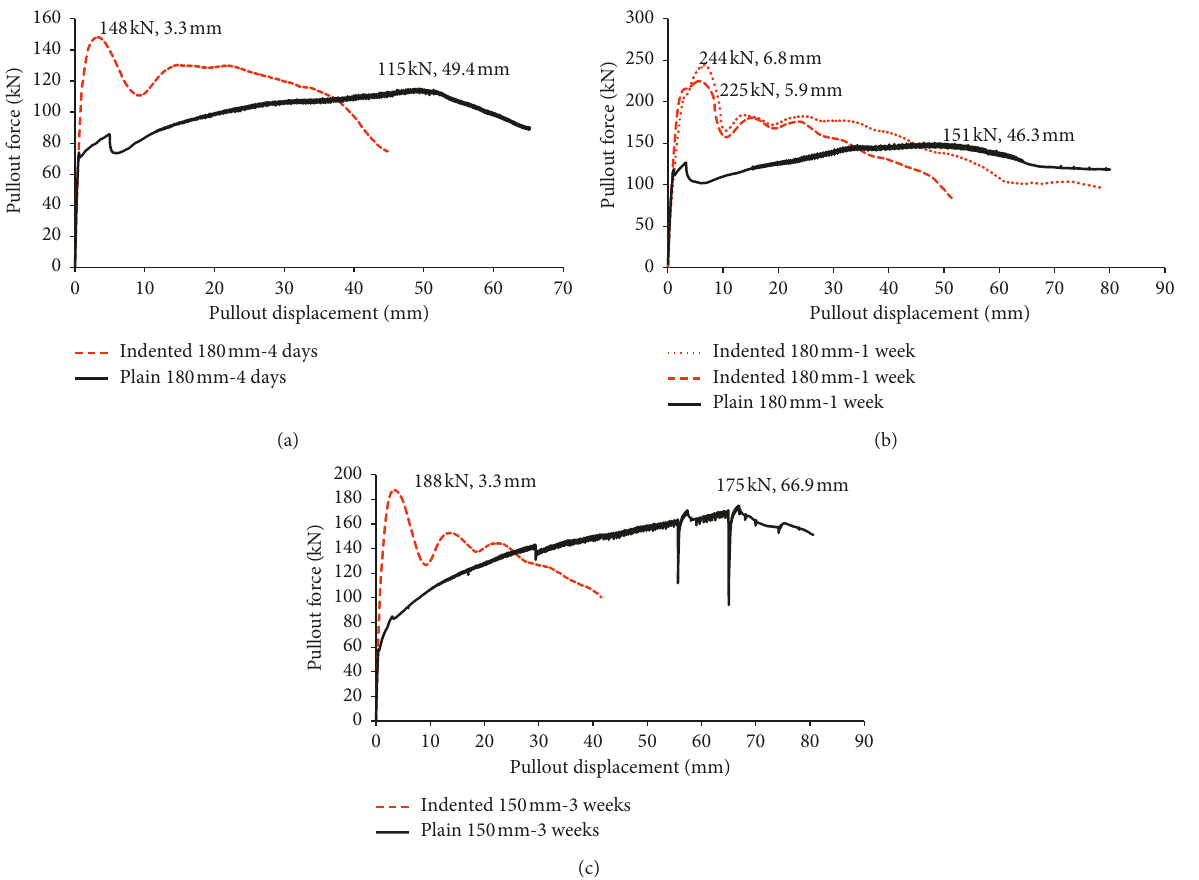
Figure 9: Load transfer characteristics of plain and indented cable bolts in DEPT. (a) 4-day-old samples with 180mm anchorage. (b) 1- week-old samples with 180mm anchorage. (c) 3-week-old samples with 150mm anchorage.